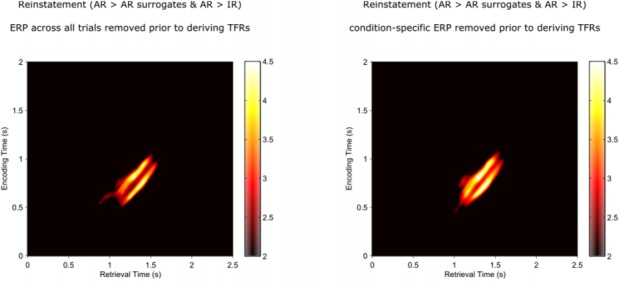
DOI:
http://dx.doi.org/10.7554/eLife.17397.016